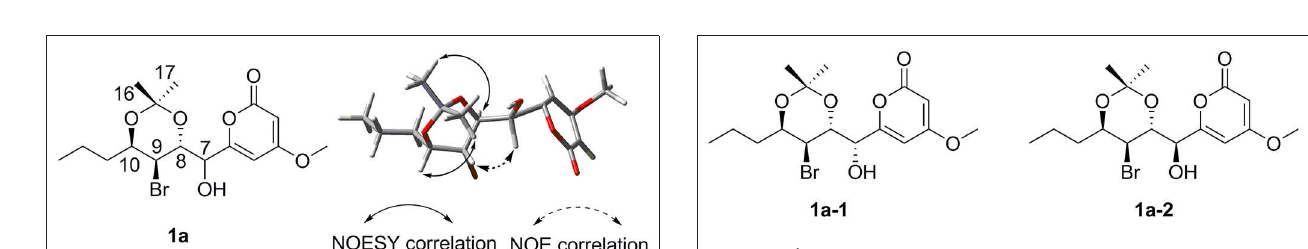
FIGURE 5 | The structures of 1a-1 and 1a-2 .